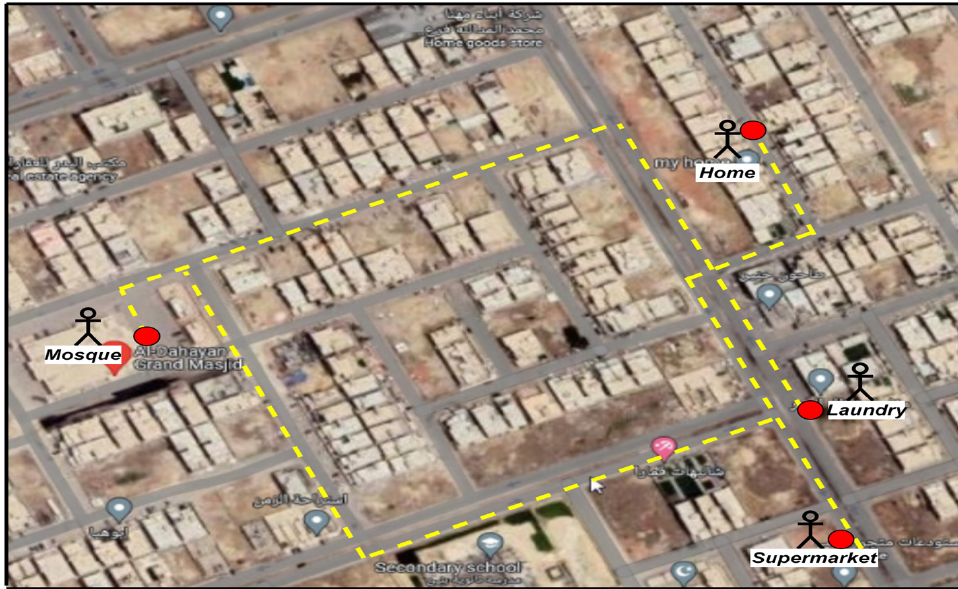
Figure 7. Navigation using the outdoor map (home to laundry). Table 5. Example for one student participant and one destination.